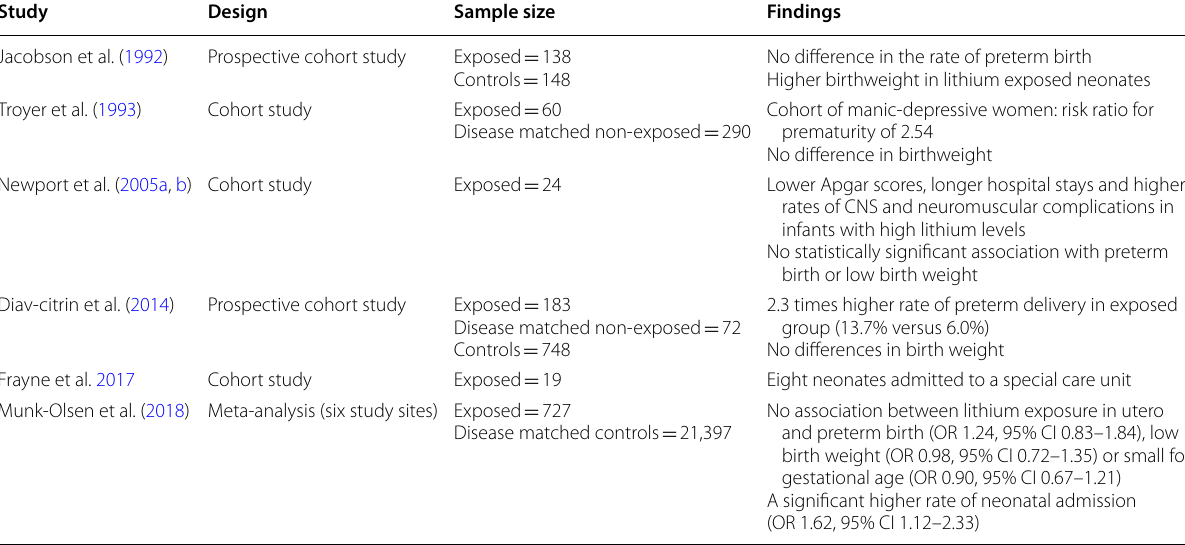
OR odds ratio, CI confidence